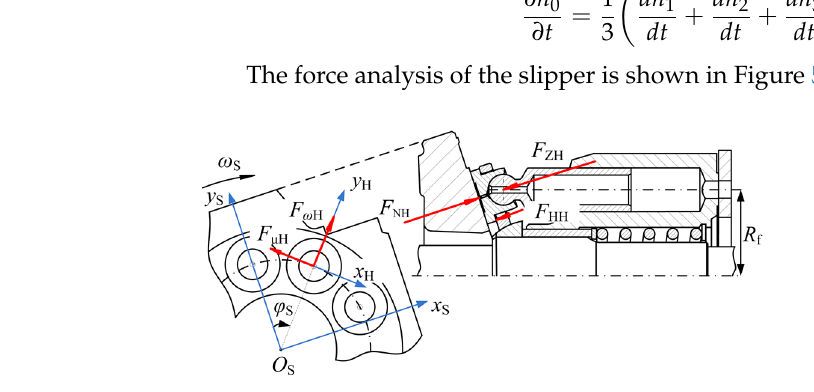
Figure 5. Force analysis of slipper.